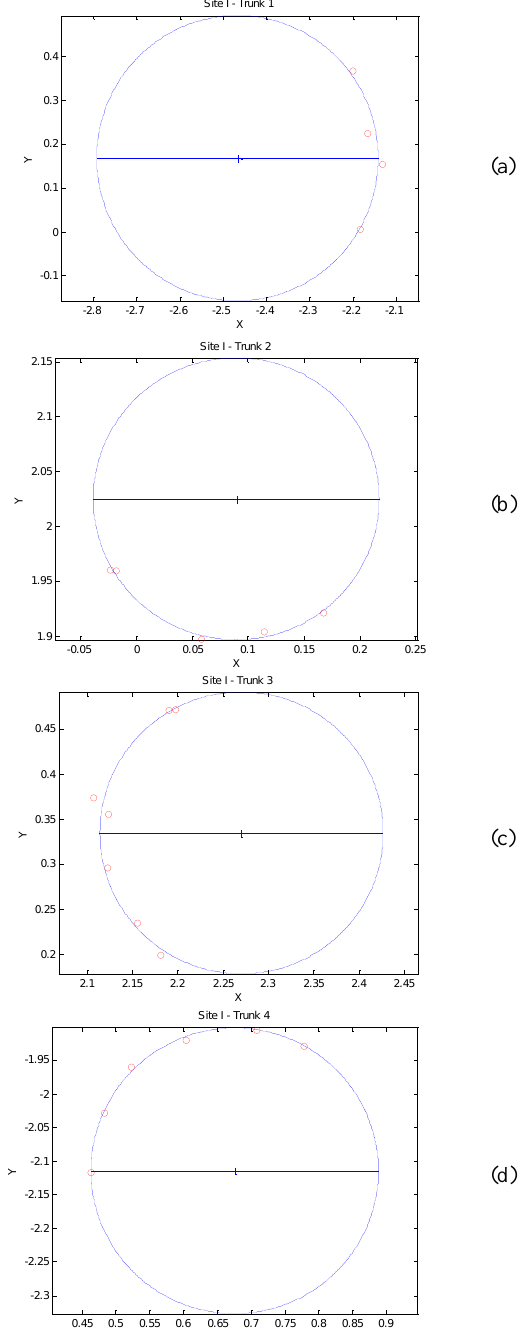
Figure 6. Circle fitted to the XY coordinates of points on the trunk surface (small red